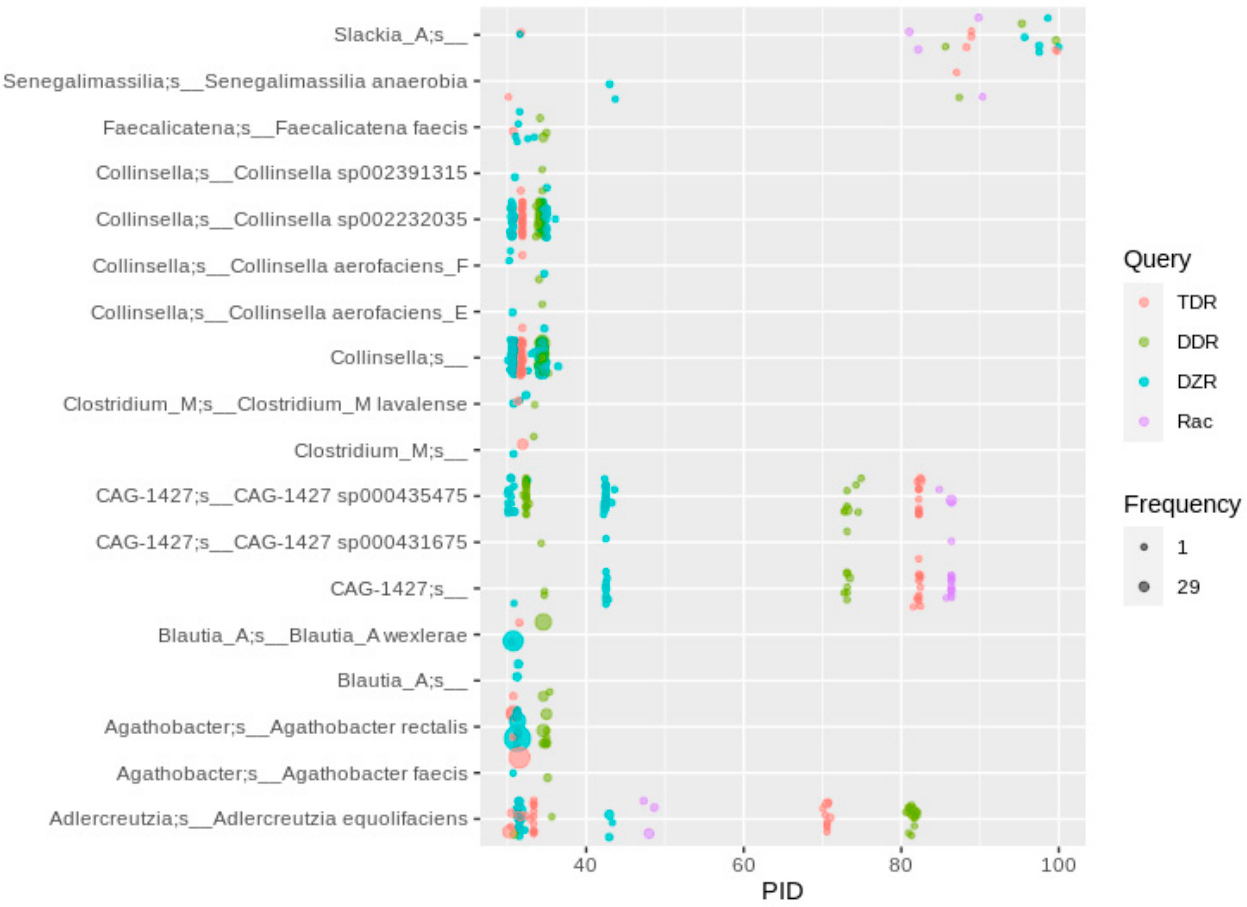
Figure 5. Homologs to enzymes involved in daidzein-to-equol transformation in human gut MAGs. Hits were filtered for the co-occurrence of all three genes required for daidzein-to-equol conversion ( dzr , ddr , tdr ) in a single MAG. For a plot showing the hits to individually occurring genes (mainly dzr ), see Supplementary Figure S7.